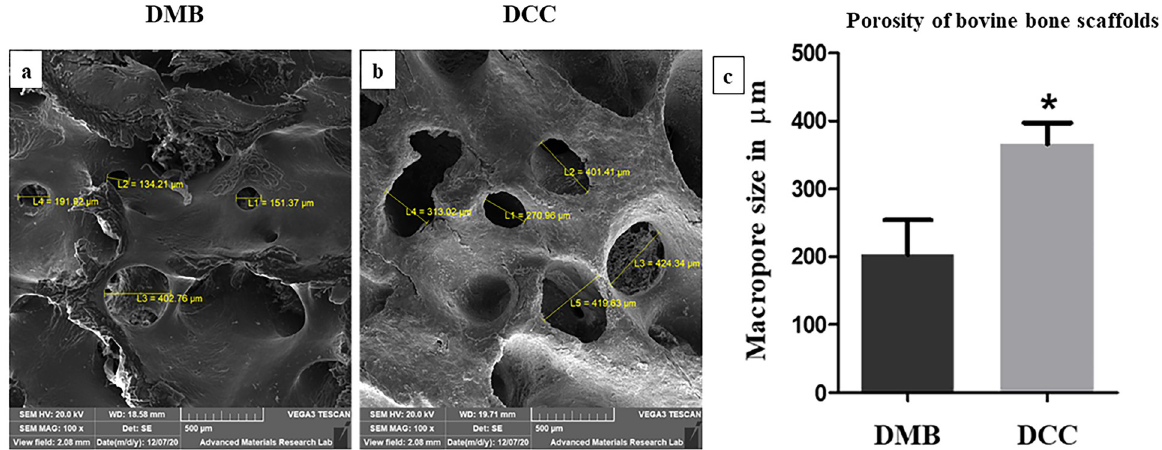
Fig 3. Variations in pore morphology related to scaffold treatment. Representative images showed pore sizes on the surface of the DMB (a) and DCC (b) scaffold. DCC scaffolds present significantly wider pore diameters with richer interconnectivity compared to DMB at 100x magnification (c) ( * p < 0.05; n =